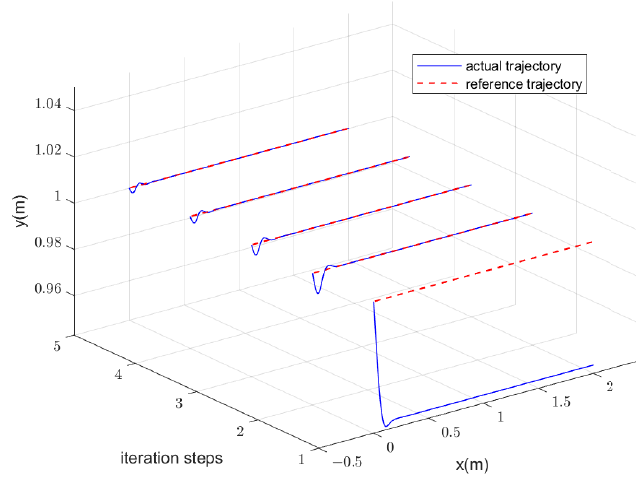
Figure 12. Iterative tracking graph under constant wind speed and water flow disturbance.